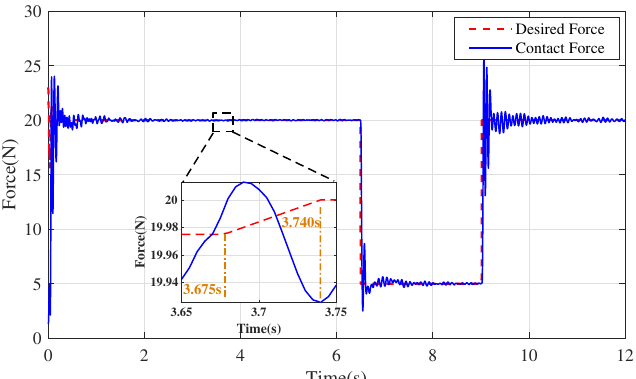
Figure 18. Impedance control without impedance matching when the polishing spindle does not rotate.